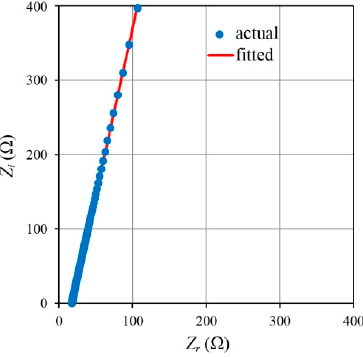
Figure 3. Typical Nyquist plot for the PhCh–(LiI:CsI:BMII) GPE.